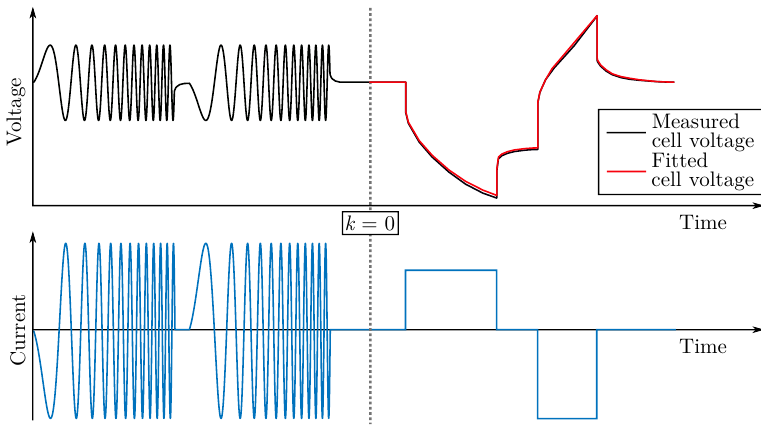
Figure 4. Schematic view of a model parameterization